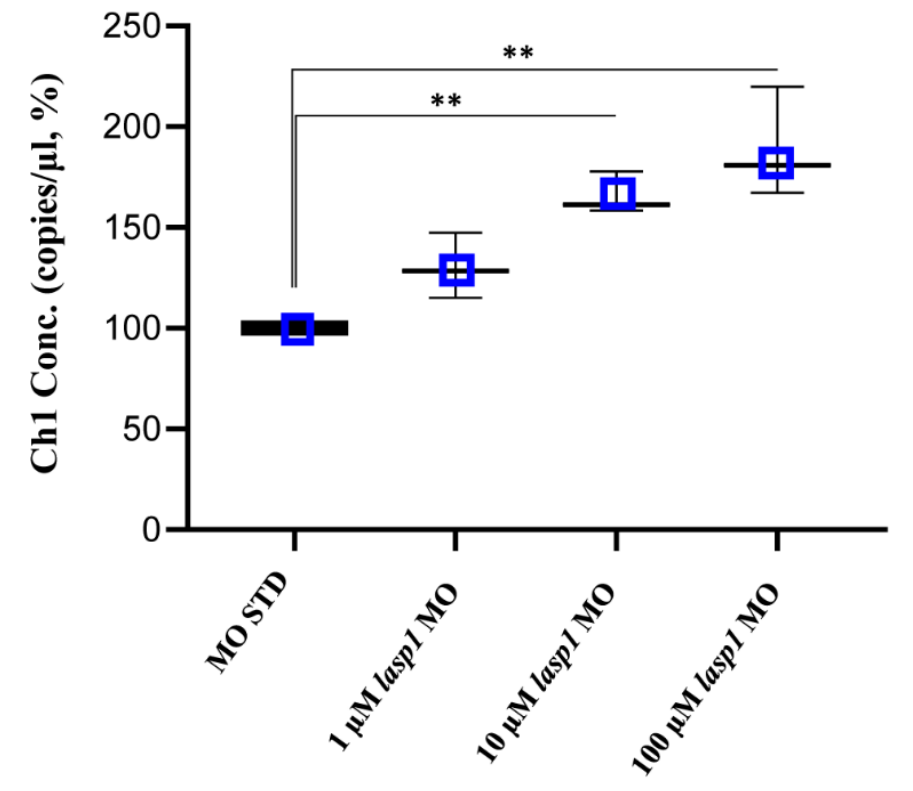
Figure 5. Absolute quantifications of lasp1 mRNA in lasp1 MO morphants using ddPCR. Dose- dependent increases in lasp1 mRNA levels were observed. The graph represents the average values of copies/ µ L referred to the MO STD samples; error bars are SDs. ** p < 0.01 in one-way ANOVA followed by Bonferroni testing.